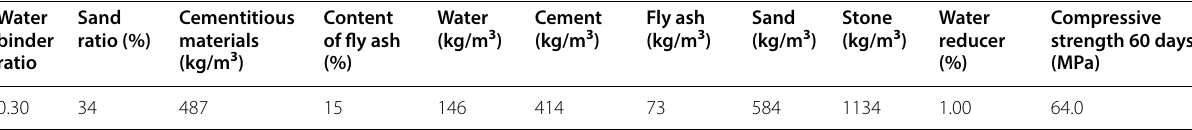
Table 1 Mix proportions of concrete. Water Sand binder ratio ratio